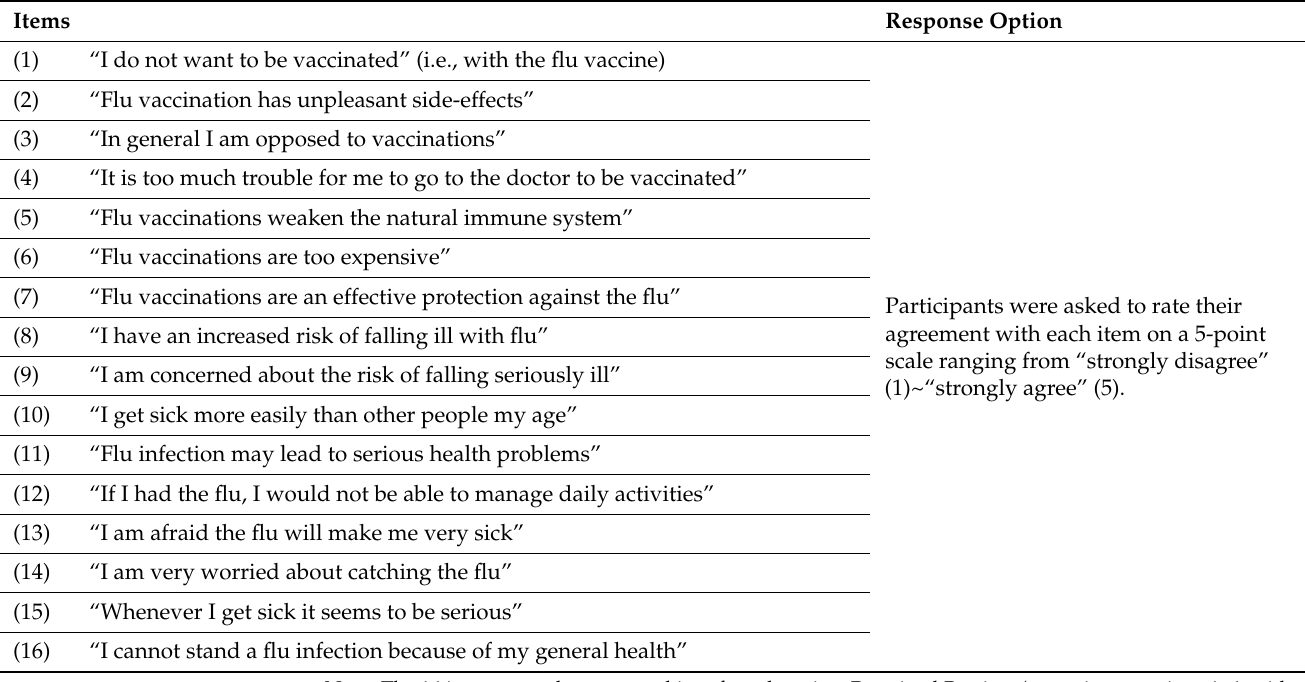
Table 1. Measure Details of Health